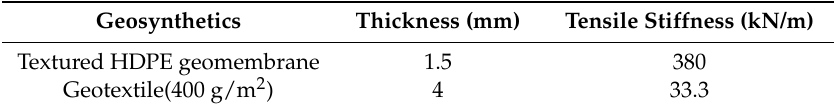
Table 2. Mechanical properties of geosynthetics (modified from Lin, 2009 [15]).